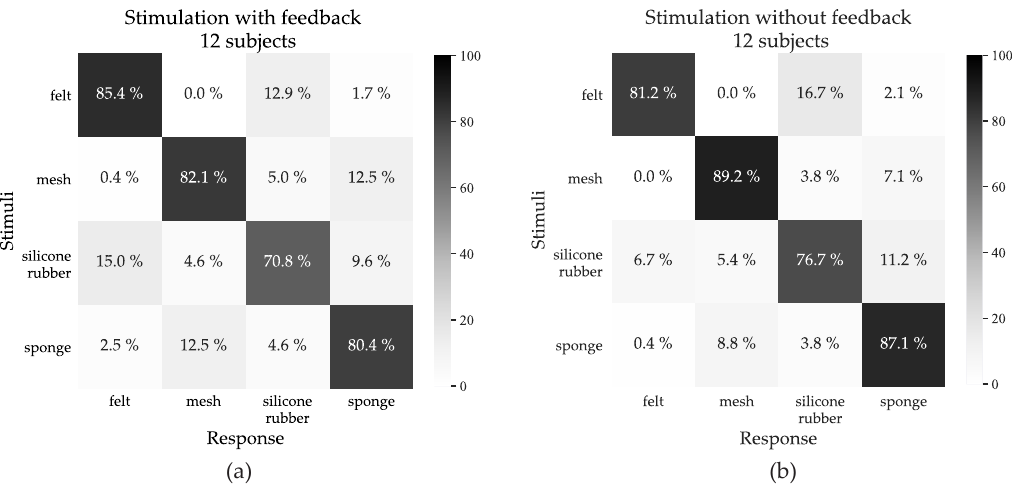
Figure 5. Confusion matrix for the identification of the different textures during the two phases. ( a ) Phase with feedback, where felt had the highest accuracy (85.4%). The lowest accuracy was when discriminating silicone rubber (70.8%), which was occasionally misinterpreted as felt (15.0%) and as sponge (9.6%). ( b ) Phase without feedback, where mesh had the highest accuracy (89.2%). In general the performance increased for all textures except felt in the phase without feedback. Mesh is easiest to discriminate (89.2%), sponge has also a high accuracy (87.1%). There was also a small improvement for the silicone texture (76.7% vs.